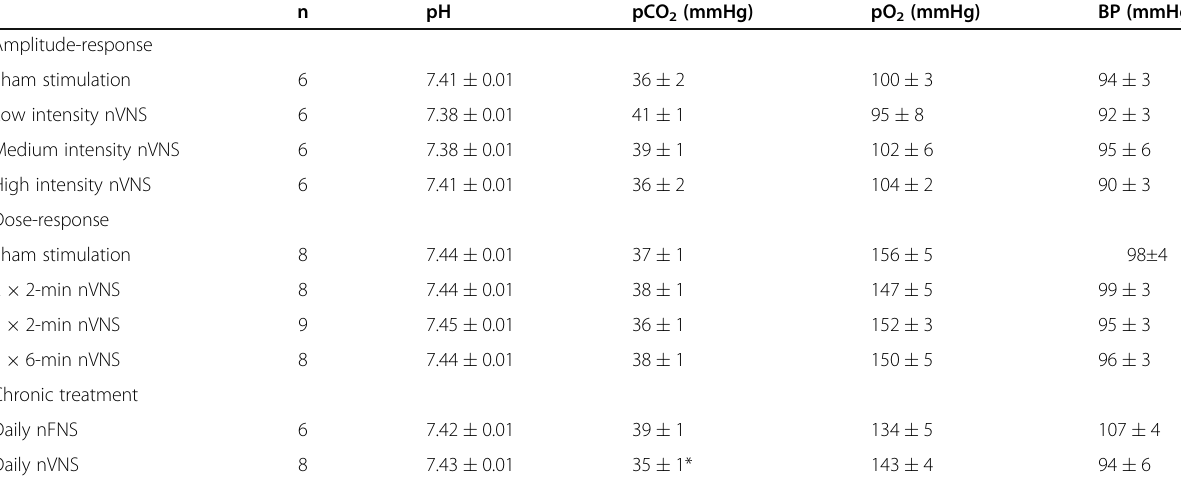
Table 1 Systemic physiology during CSD recording in different nVNS paradigms n pH pCO 2